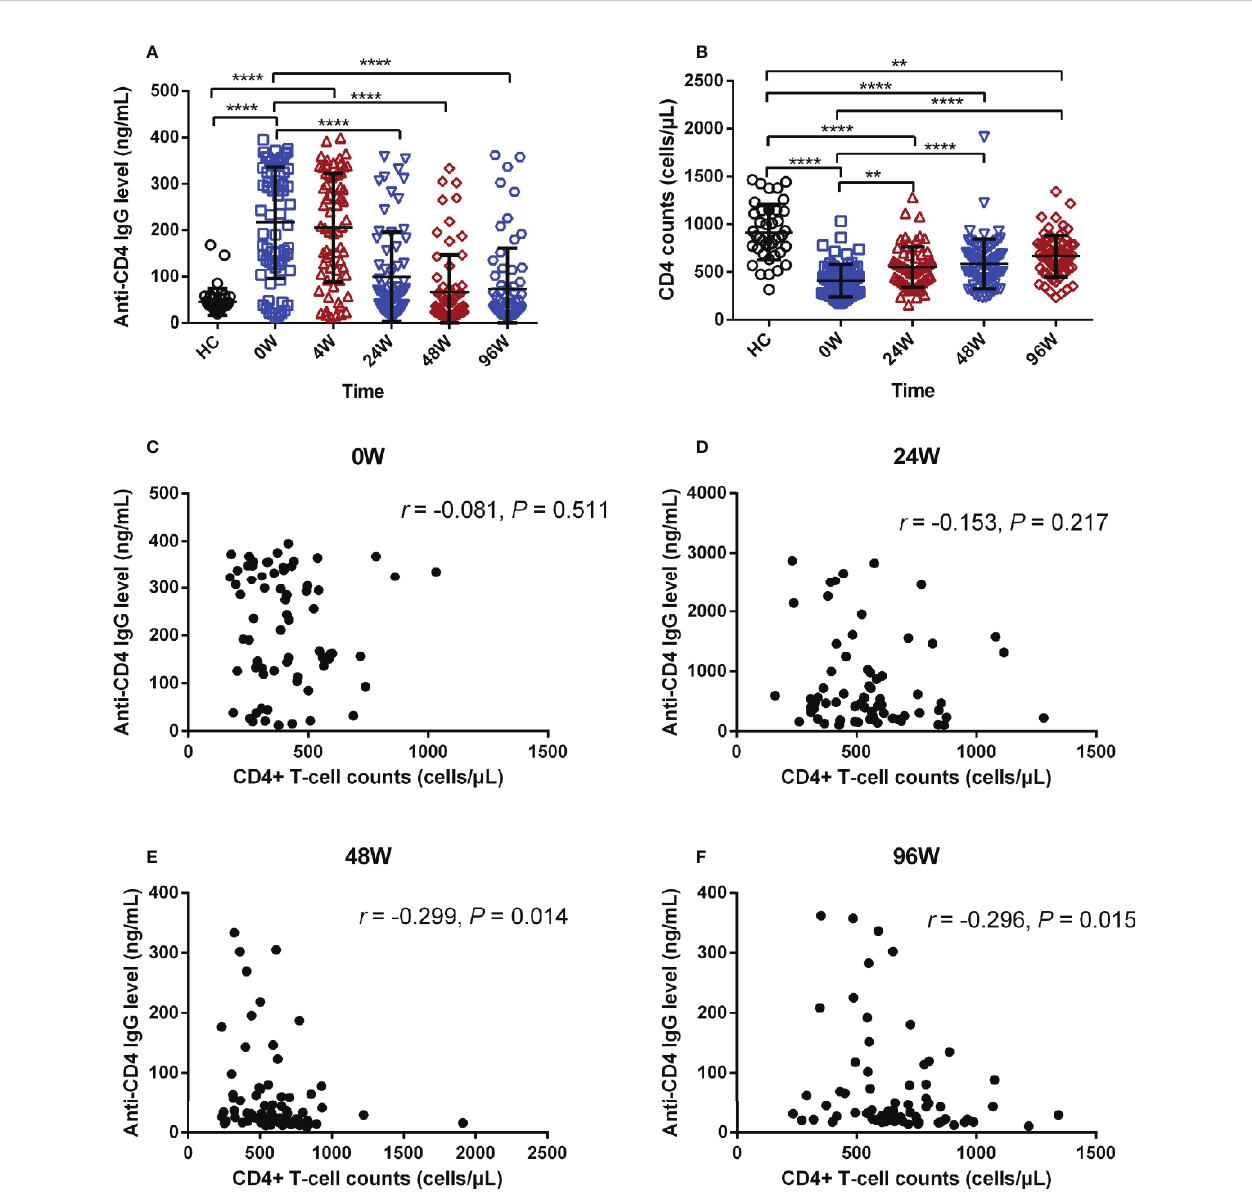
FIGURE 2 | The Dynamic Changes of Anti-CD4 IgG Levels in AHI Individuals After Early ART. Plasma anti-CD4 IgG levels (A) at 0 ( □ ), 4 ( △ ), 24 ( ▽ ), 48 ( ◇ ), and 96 W ( ○ ), and CD4 + T-cell counts (B) in healthy controls (n = 40) and AHI (n = 69) individuals at 0 ( □ ), 24 ( △ ), 48 ( ▽ ), and 96 W ( ◇ ) after early ART. Correlations between plasma levels of anti-CD4 IgG and peripheral CD4 + T-cell counts in AHI individuals at 0 (C) , 24 (D) , 48 (E) , and 96 W (F) after early ART. One-way ANOVA tests and Spearman ’ s rank correlation tests, with P < 0.05 considered signi fi cant. ** P < 0.01, **** P <